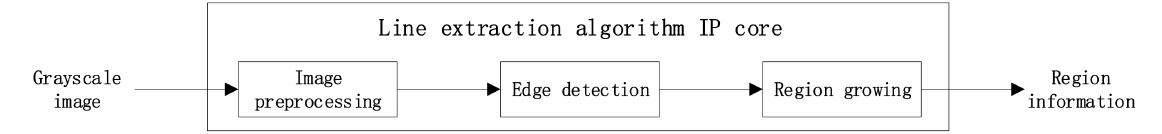
Figure 2. Line segment detection algorithm IP core.